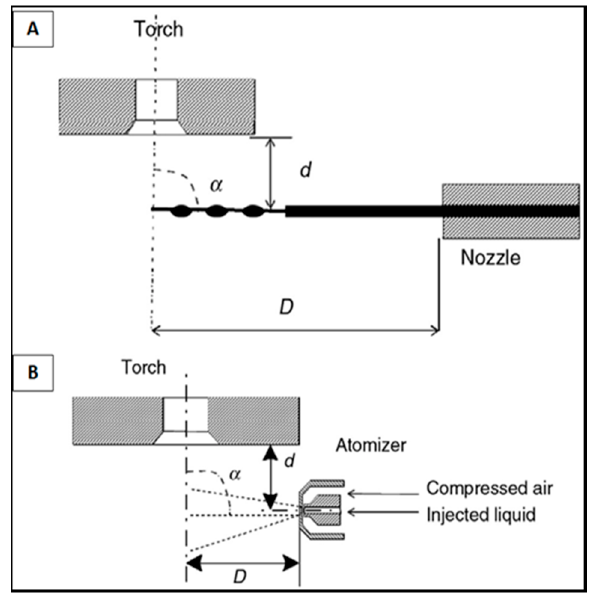
Figure 5. Schematic representation of the ( A ) mechanical injection and ( B ) spray atomization under external injection mode. Reproduced with permission from [17], Elsevier, 2009.